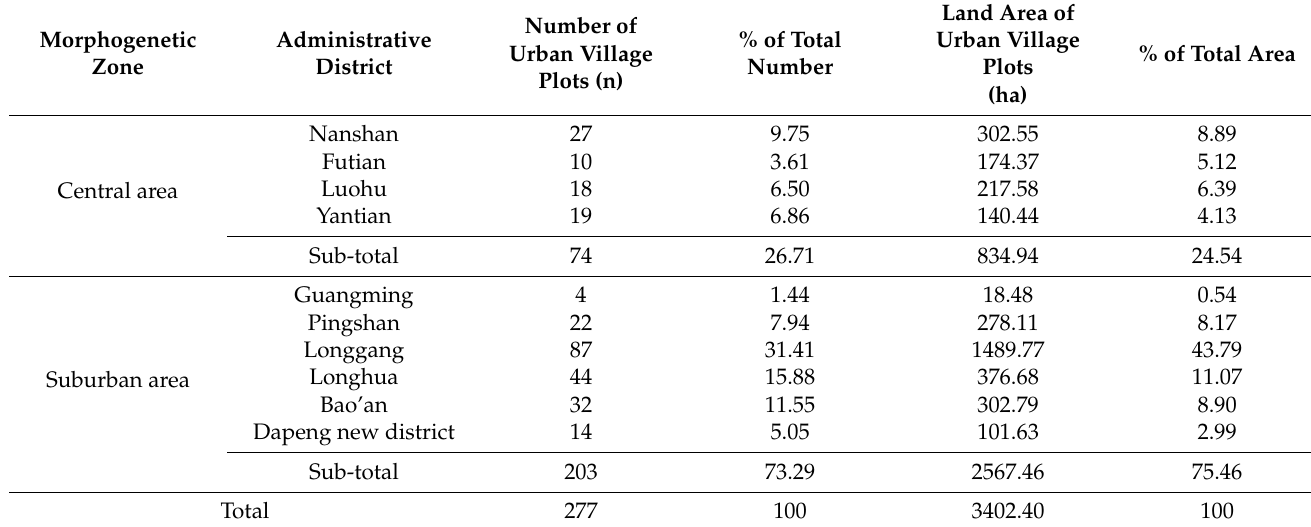
Table 1. Quantity and area distribution of urban village redevelopment.